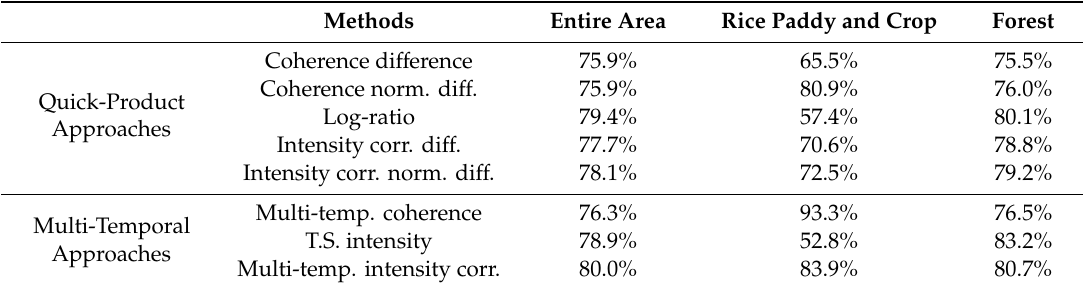
Figure 10. Comparison between the ( a ) multi-temporal coherence, ( b ) multi-temporal intensity correlation and ( c ) time-series intensity methods. Yellow-red pixels indicate high probability of landslides. Table 2. Overall accuracy over the land use